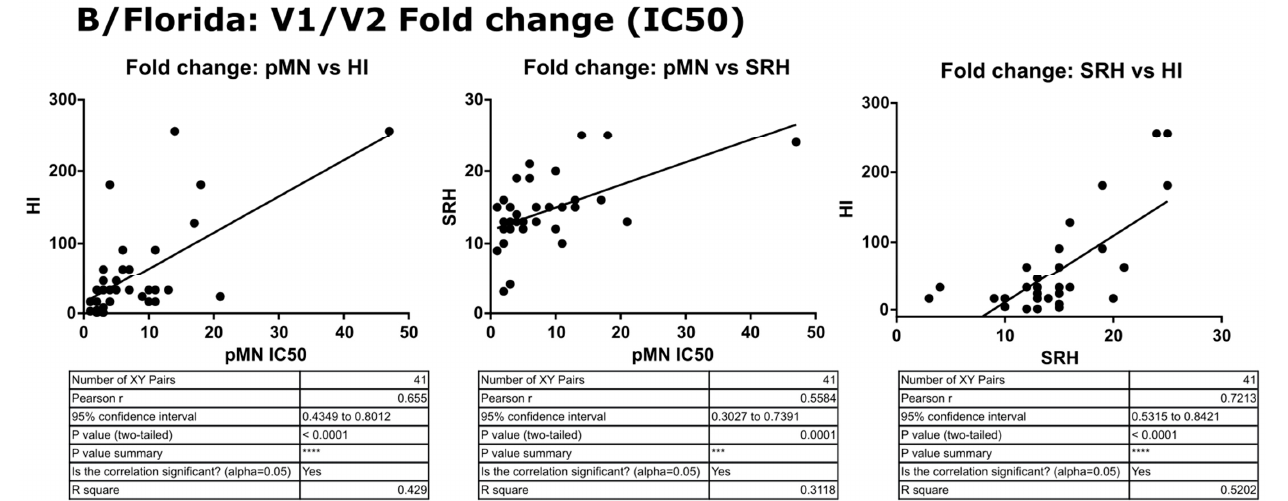
Figure 12. Correlation of SRH, HI and pMN (IC 50 ) V1 to V2 fold change values assayed against B/Florida/4/2006 PV. Pearson’s two-tailed analysis performed using GraphPad Prism. Strong correlation was seen between fold change in pMN and HI values between V1 and V2 antibody titres (IC 50 ), Pearsons r = 0.65. pMN and SRH V1/V2 fold changes correlated well, Pearsons r = 0.55 and strong correlation was observed for V1/V2 fold change for antibody titres of SRH and HI (Pearsons r = 0.72). p ≤ 0.001 = ***, p ≤ 0.0001 = ****.